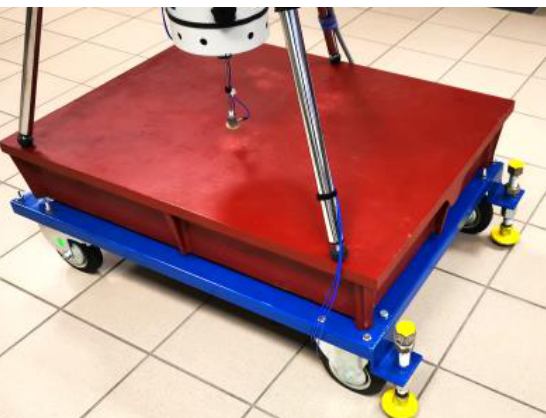
Figure 3. Base of the test stand (100 cm × 75 cm) with a visible supporting structure with a set of 3 swivel wheels and a three-point screw mechanism used in the measurement mode.